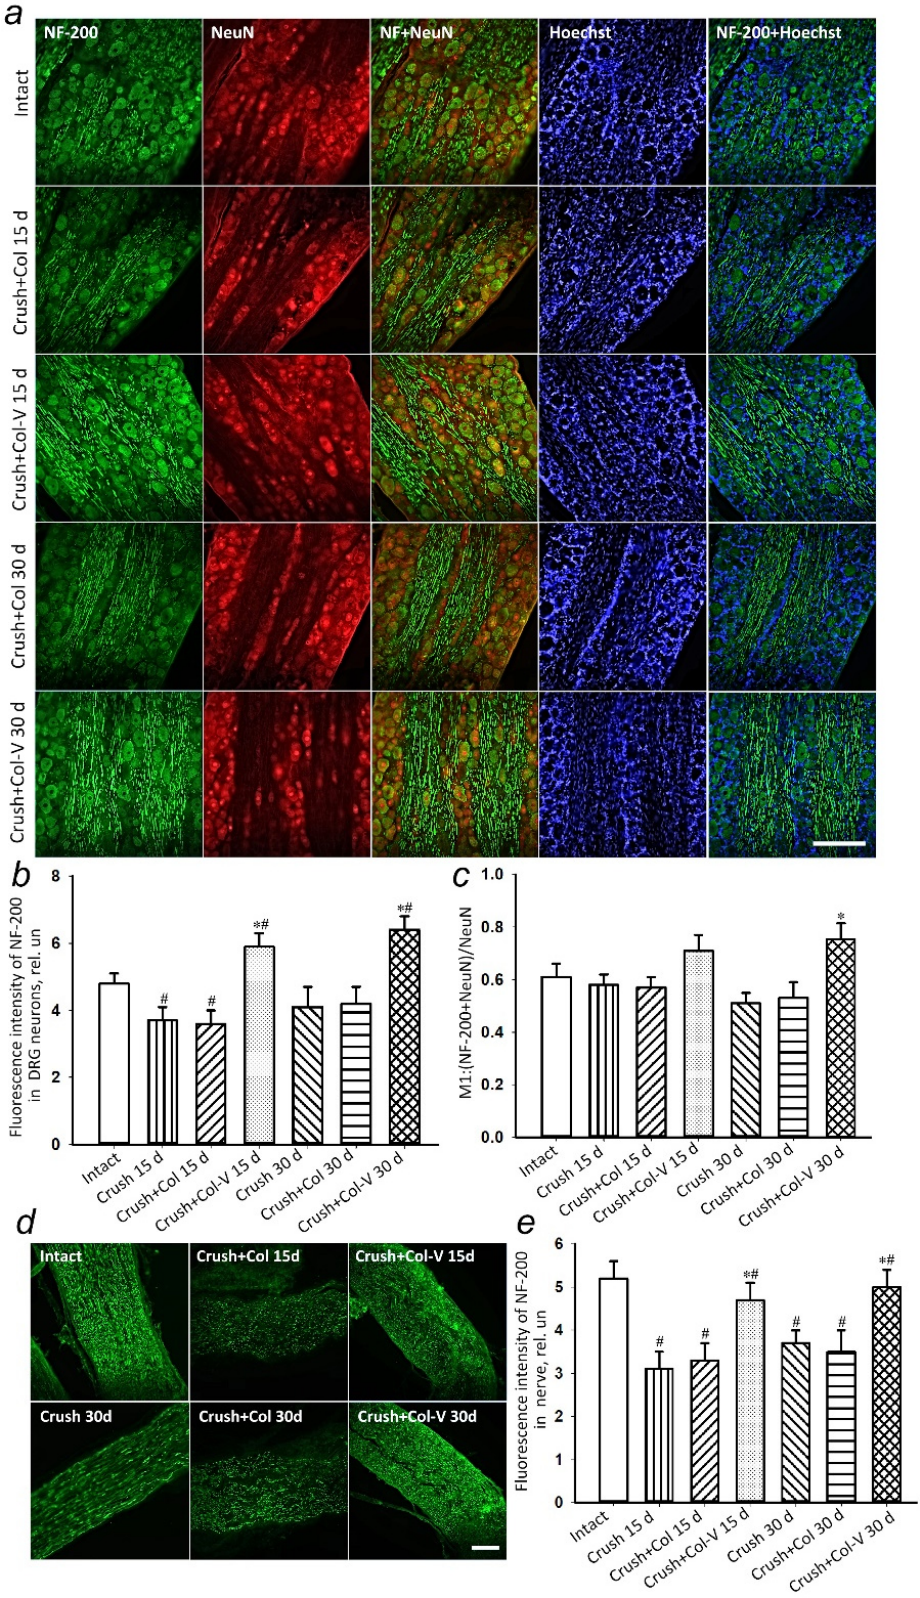
Figure 5. ( a ) Representative immunofluorescence images of NF-200 protein (green), combined fluorescence images of NF-200 and NeuN (red, neuronal marker), and combined fluorescence images of NF-200 and Hoechst (nuclear marker, blue) in rat dorsal root ganglia (DRG) 15 days (Crush and Crush+Col 15 d) and 30 days (Crush and Crush+Col 30 d) after injury and with applied only gel or vesicle gel preparation applied to the injured nerve (Crush +Col-V 15 d and 30 d, respectively). Scale bar: 50 µm. ( b ) Relative fluorescence intensity of NF-200 in DRG neurons at different times after crush, without and with the vesicle preparation applied. ( c ) Changes in Manders’ M1 colocalization coefficient of NF-200 protein and neuronal marker NeuN. ( d ) Immunofluorescence of NF-200 15 and 30 days in sciatic nerve after the injury: Int, intact nerve; Crush, crushing without gel applica- tion; Crush+Col, crushing with collagen gel application without vesicles; Crush+Col-V, crushing with the application of vesicle-containing gel. ( e ) Relative fluorescence intensity of NF-200 in the sciatic nerve; n = 7 (mean fluorescence intensity of NF-200 in three DRG slices (at least 100 neurons) or the nerve (general immunofluorescence) from seven animals of each experimental group). M ±